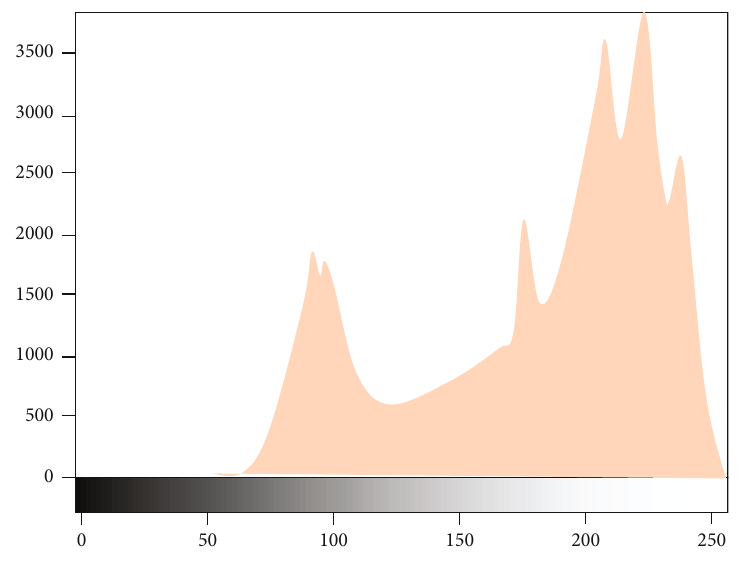
Figure 6: Lena graph R channel histogram.